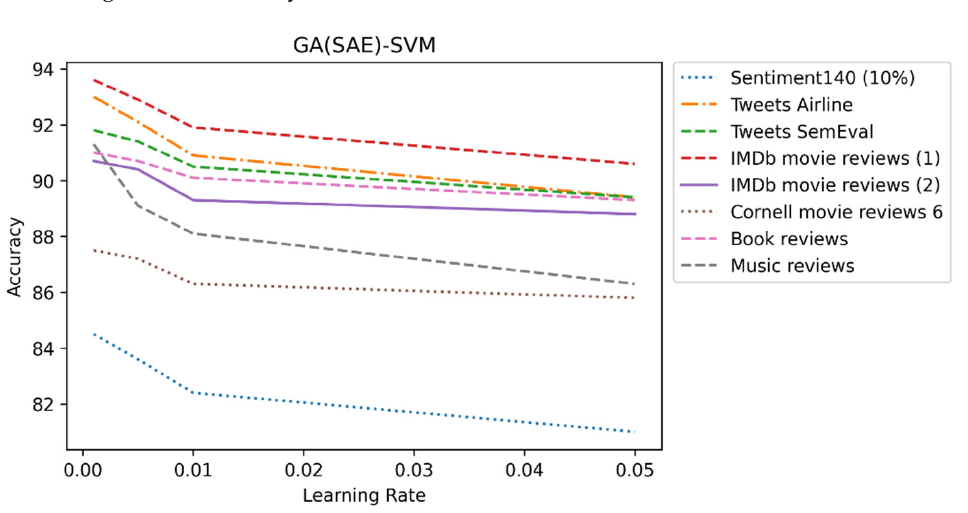
Figure 6. Learning rate impact of GA(SAE)-SVM on all datasets.